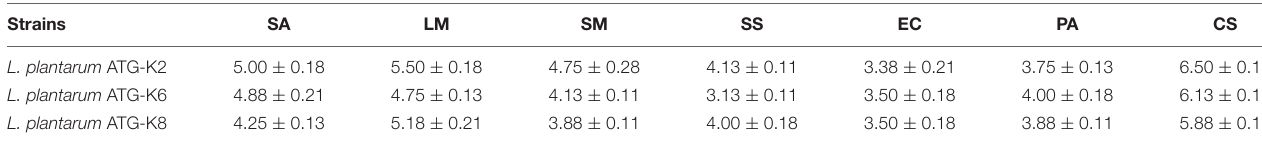
TABLE 1 | Antibacterial effects of Lactobacillus plantarum strains ATG-K2, ATG-K6, and ATG-K8 against Staphylococcus aureus (SA), Listeria monocytogenes (LM), Streptococcus mutans (SM), Streptococcus salivarius (SS), Escherichia coli (EC), Pseudomonas aeruginosa (PA), and Cronobacter sakazakii (CS) determined by disc diffusion assay.